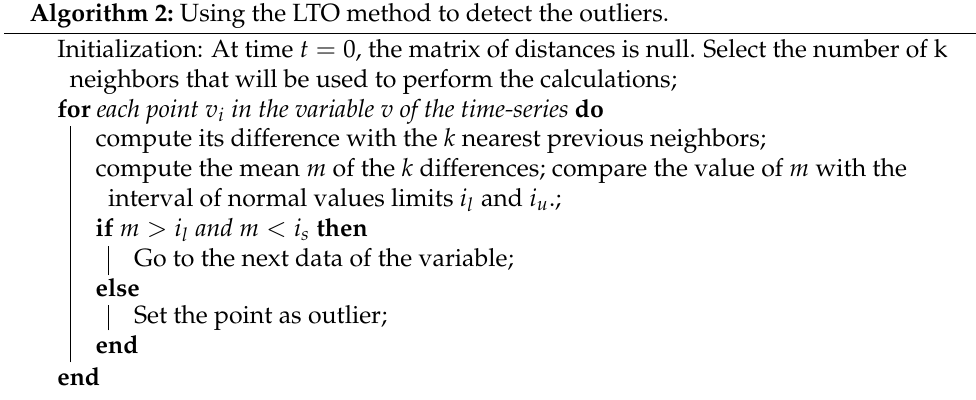
Algorithm 2: Using the LTO method to detect the